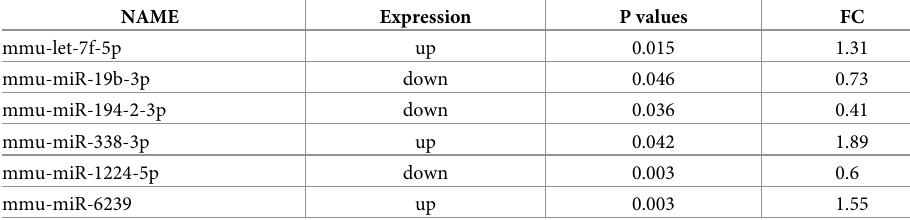
Table 1. miRNA expression profile in the liver tissue of mice treated with